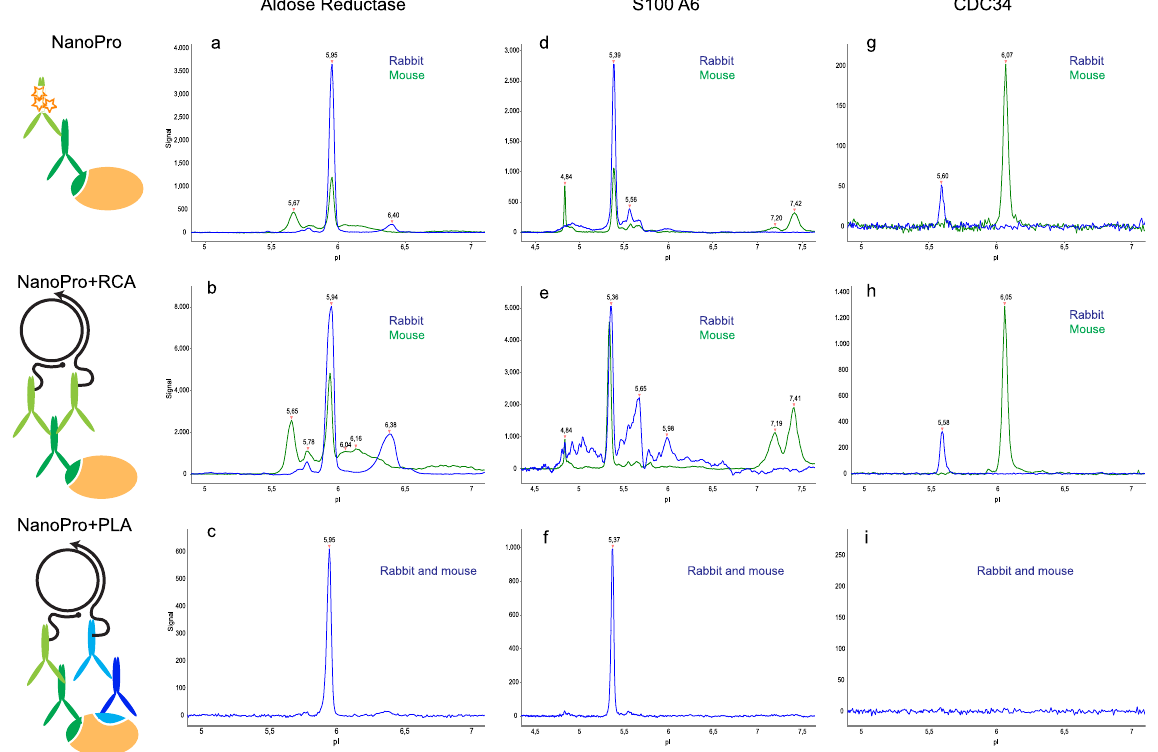
Figure 5. Detection of proteins by antibody pairs in NanoPro + PLA. Aldose reductase ( a–c ), S100A6 (panels d–f ) and CDC34 (panels g–i ) were detected in 50 µ g/ml HDMEC cell lysates using different protocols. In ( a , d and g ), the standard NanoPro assay was used with monoclonal mouse antibodies (blue) or rabbit affinity purified polyclonal antibodies (green). Panels ( b,e and h ) display results when the same antibodies were applied in NanoPro + RCA. Panels ( e,f and i ), illustrate results when recognition depended on binding by both the mouse and rabbit antibodies in NanoPro + PLA. Schematic representation of different assay formats, are shown left of the